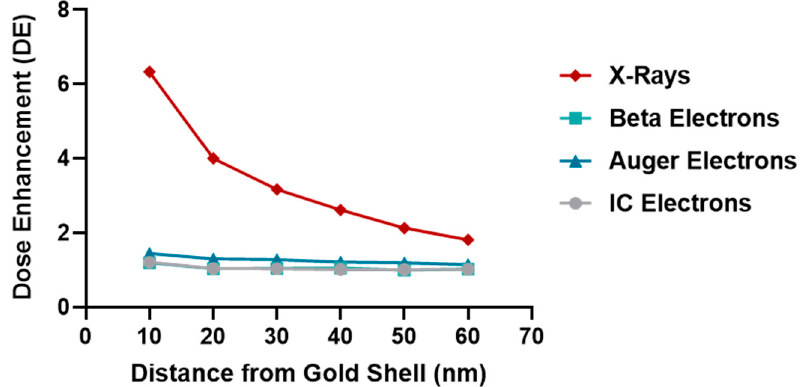
Figure 8. Dose enhancement (DE) factors calculated for the different 177 Lu radiation emissions, considering the first six water shells with a thickness of 10 nm around the gold shell (see the Materials and Methods Section for geometry setup).